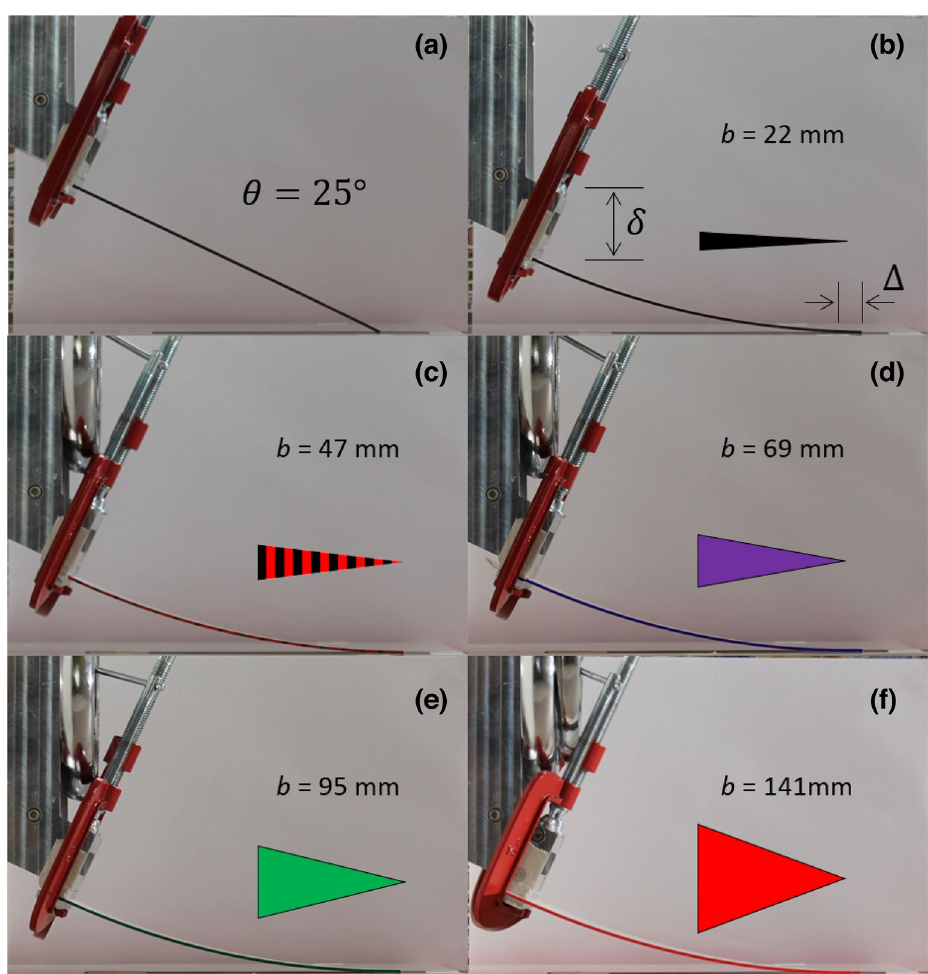
Figure 3. Photographs of the skate and overtravel of triangular cantilevers inclined at 25° to the horizontal. ( a ) A triangular cantilever in contact with the surface. ( b – f ) The triangular cantilevers are shown when the tip is tangent to the surface. In each case the length of the triangular cantilever is 190